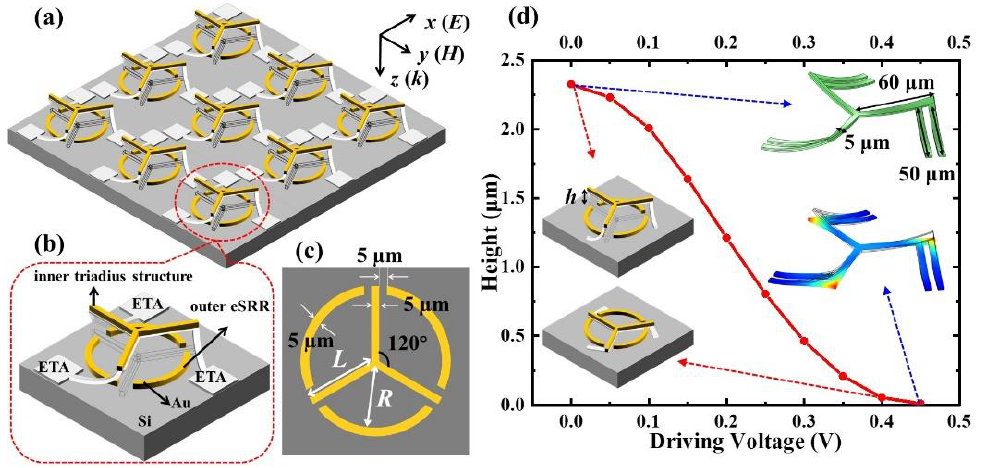
Figure 1. Schematic drawing of ( a ) MEMS-based TTM and ( b ) unit cell in detail. ( c ) Top view of TTM unit cell and the corresponding geometrical denotations. ( d ) Relationship of driving voltages and elevating heights ( h ) of TTM with ETA. Inserted images are the ETA simulations.